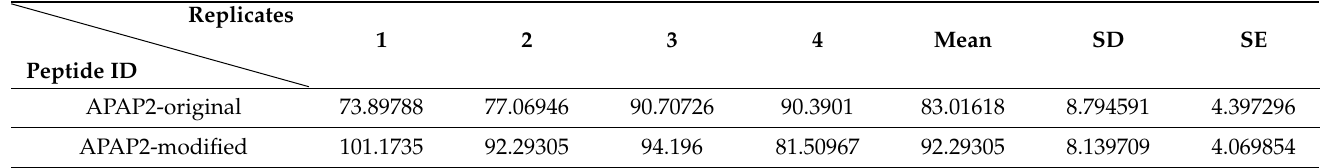
Table 4. Percentage of cell viability of human fibroblast cell line treated with APAP2-original and -modified peptides for 24